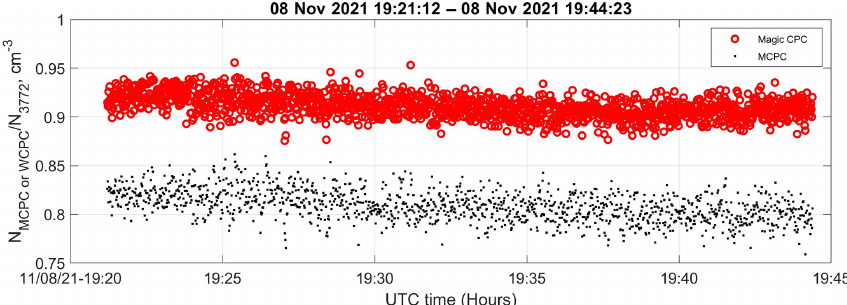
Figure 10. Aerosol total number concentration comparison between the MCPC and the Magic CPC against the AGMS CPC 3772 before the flight on 8 November 2021.